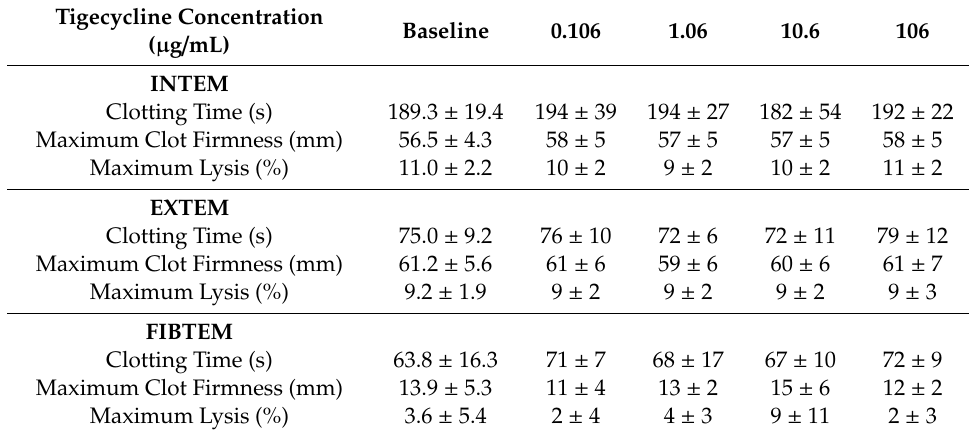
Table 3. Rotational thromboelastometry after addition of tigecycline in increasing concentrations in blood samples of healthy volunteers ( n = 14).